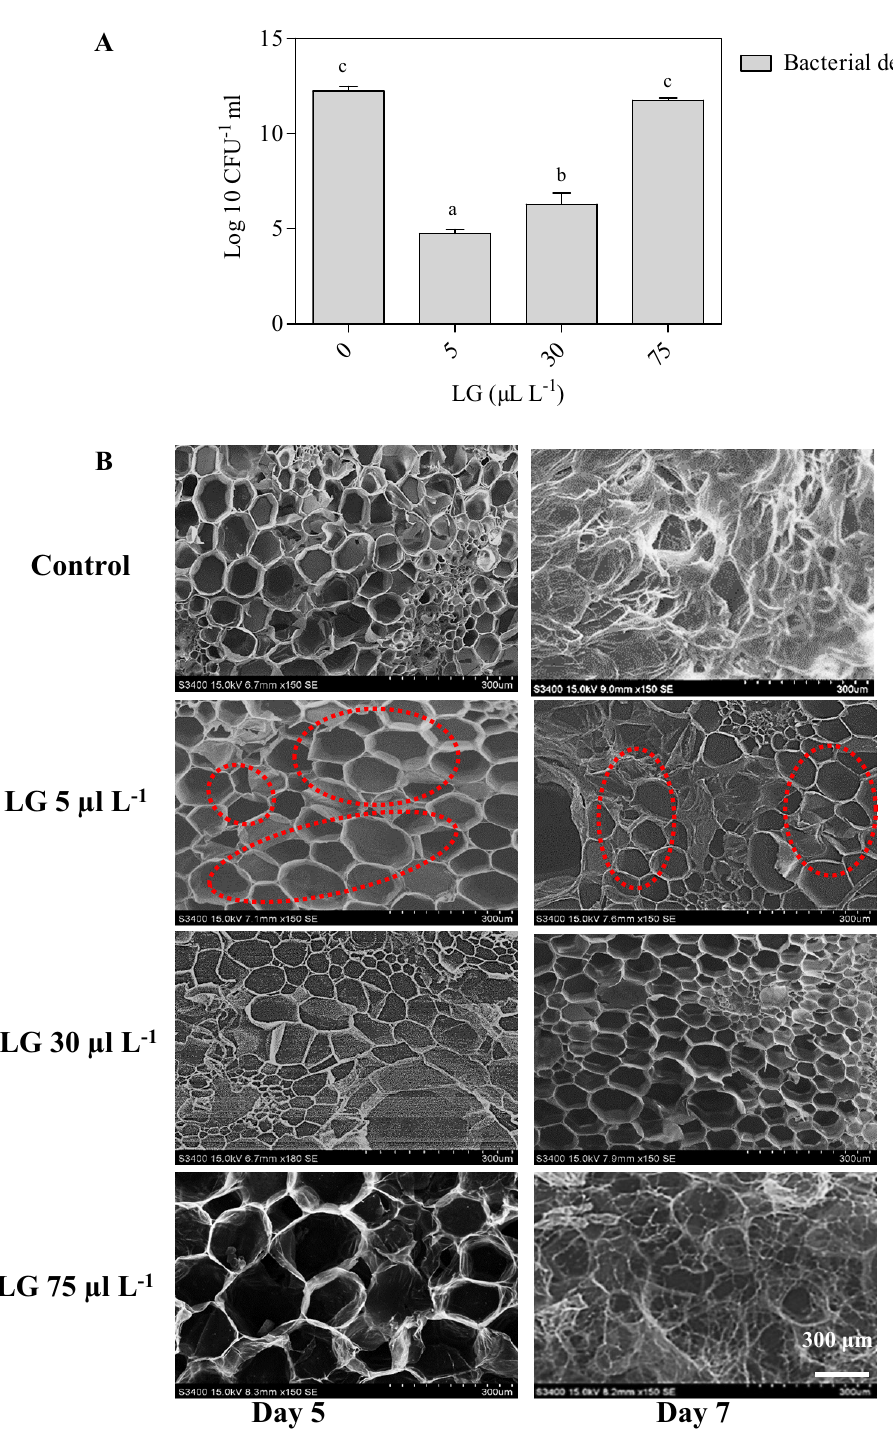
Figure 3. ( A ) Bacterial count in untreated (control) and LG essential oil (5, 30 and 75 µl L −1 ) treated cut spikes of Gladiolus at 5th day. Each value is the mean ± SE of three replicates. Means with different letters are significantly different at 5% probability (Tukey’s test). ( B ) SEM characterization of stem ends of untreated and LG essential oil (5, 30 and 75 µl L −1 ) treated spikes of Gladiolus grandifloras Observations were carried out on 5th and 7th day. Scale bars: 300 μm. Red circle indicates intact vasculature with lesser